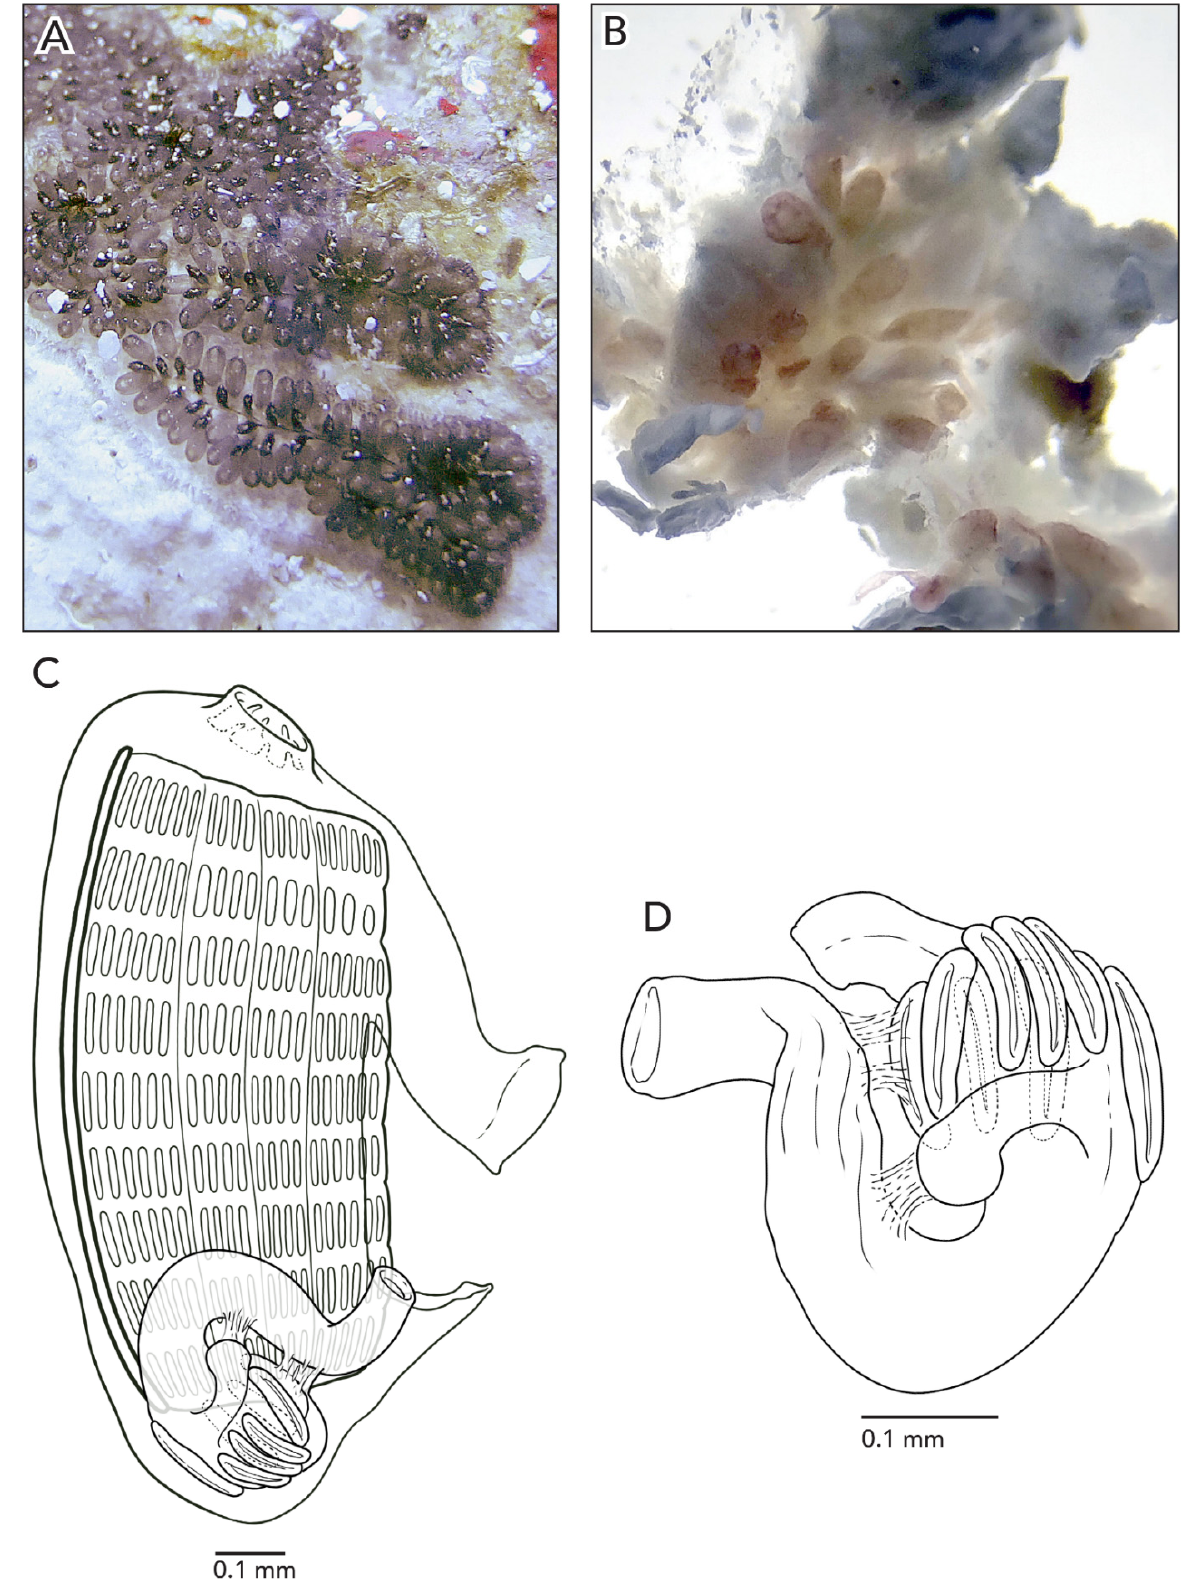
Figure 8. Botryllus nortensis sp. nov. ( A ) Live colony on a natural substrate (dead coral) ( B ) Preserved colony ( C ) Left side view of a zooid. ( D ) Detail of the abdomen region.